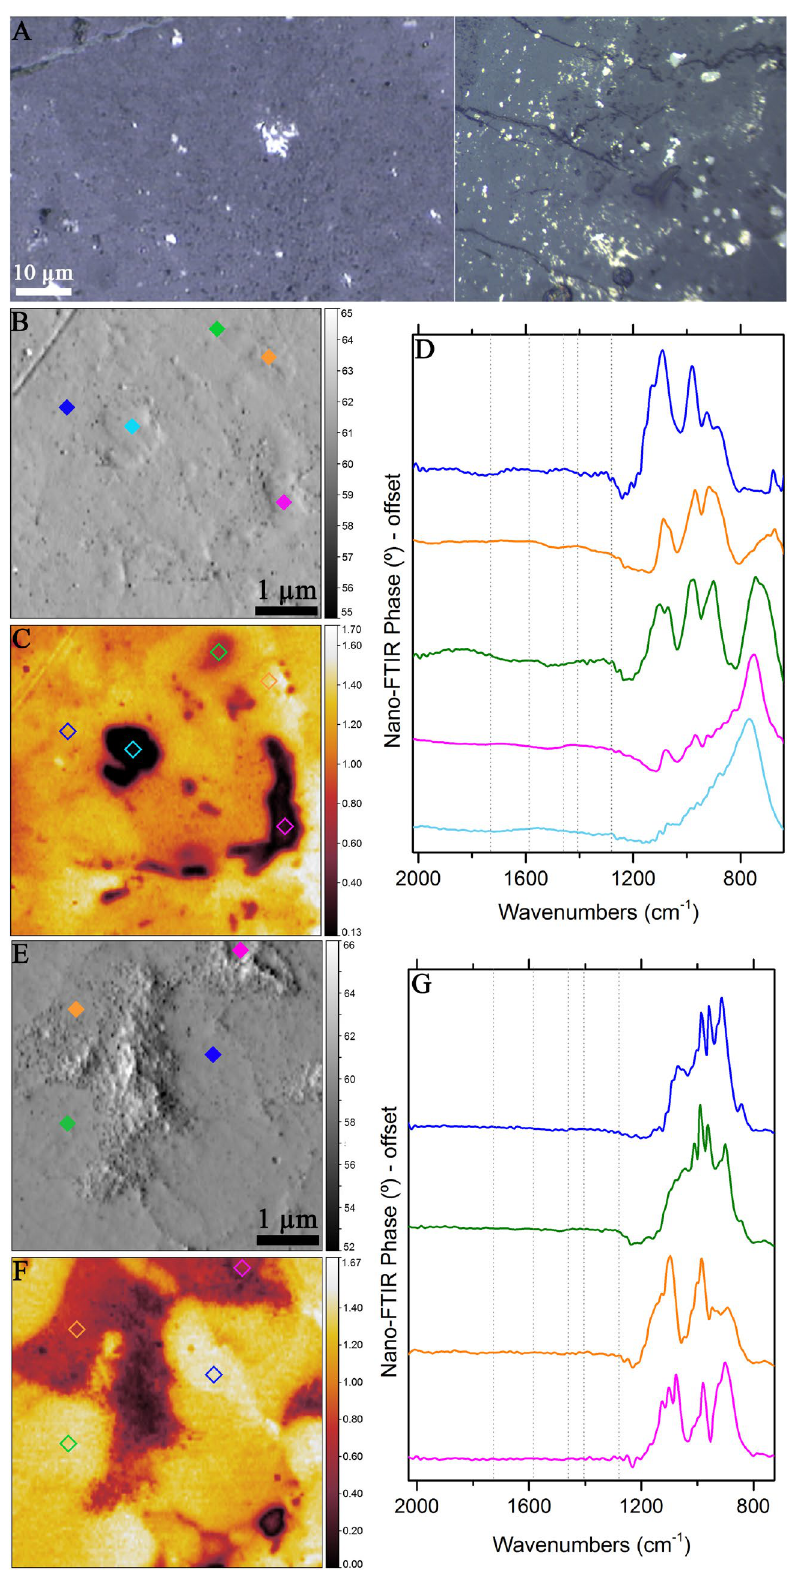
Figure 5. Nano-FTIR spectroscopic results of QUE 97344. ( A ) Visible micrograph of QUE 97344. ( B , E ) and ( C , F ) show, respectively, mechanical and optical amplitude images of the two locations on QUE 93744. Diamonds denote the points from where spectra were collected. ( D , G ). Corresponding color-coded nano-FTIR spectra, indicating presence of silicate bands and absence of the organic bands. Dotted vertical lines indicate positions of organics observed in DOM